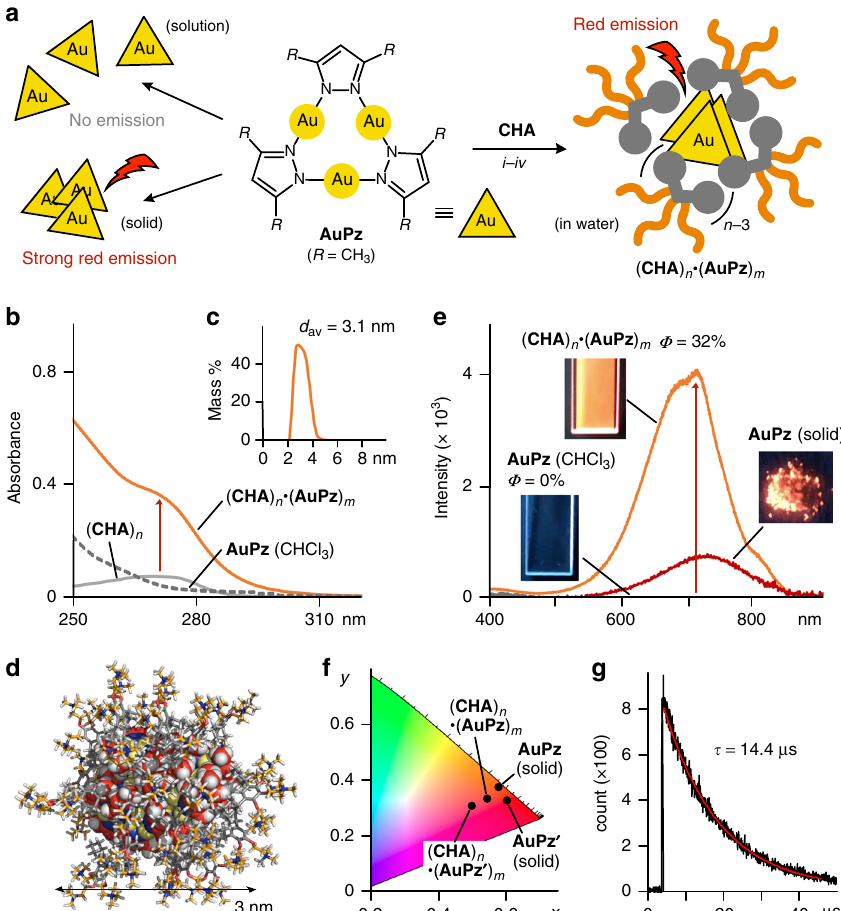
Fig. 5 Uptake-induced solution-state emission of metal-complexes by the cycloalkane-based micelle. a Schematic representation of the emission properties of AuPz in solution and the solid state, and upon uptake by ( CHA ) n in water through ( i ) grinding, ( ii ) water addition, ( iii ) centrifugation, and ( iv ) fi ltration. b UV – visible spectra (H • ( AuPz ) 2 O, room temperature, 1.0 mM based on the amphiphiles) of ( CHA ) n m , ( CHA ) n , and AuPz in CHCl 3 (0.1 mM). c DLS chart of ( CHA ) n • ( AuPz ) m and d optimized structure of ( CHA ) 22 • ( AuPz ) 12 (white: hydrogen; gray, orange, and scarlet: carbon, red: oxygen, blue: nitrogen, yellow: gold). e Emission spectra (room temperature, λ ex = 290 nm) and photographs ( λ ex = 254 nm) of ( CHA ) n • ( AuPz ) m in H 2 O, and AuPz in CHCl 3 (0.1 mM) and the solid state. f CIE coordinate diagram (H 2 O, room temperature) of ( CHA ) n • ( AuPz ) m , ( CHA ) n • ( AuPz ′ ) m , AuPz , and AuPz ′